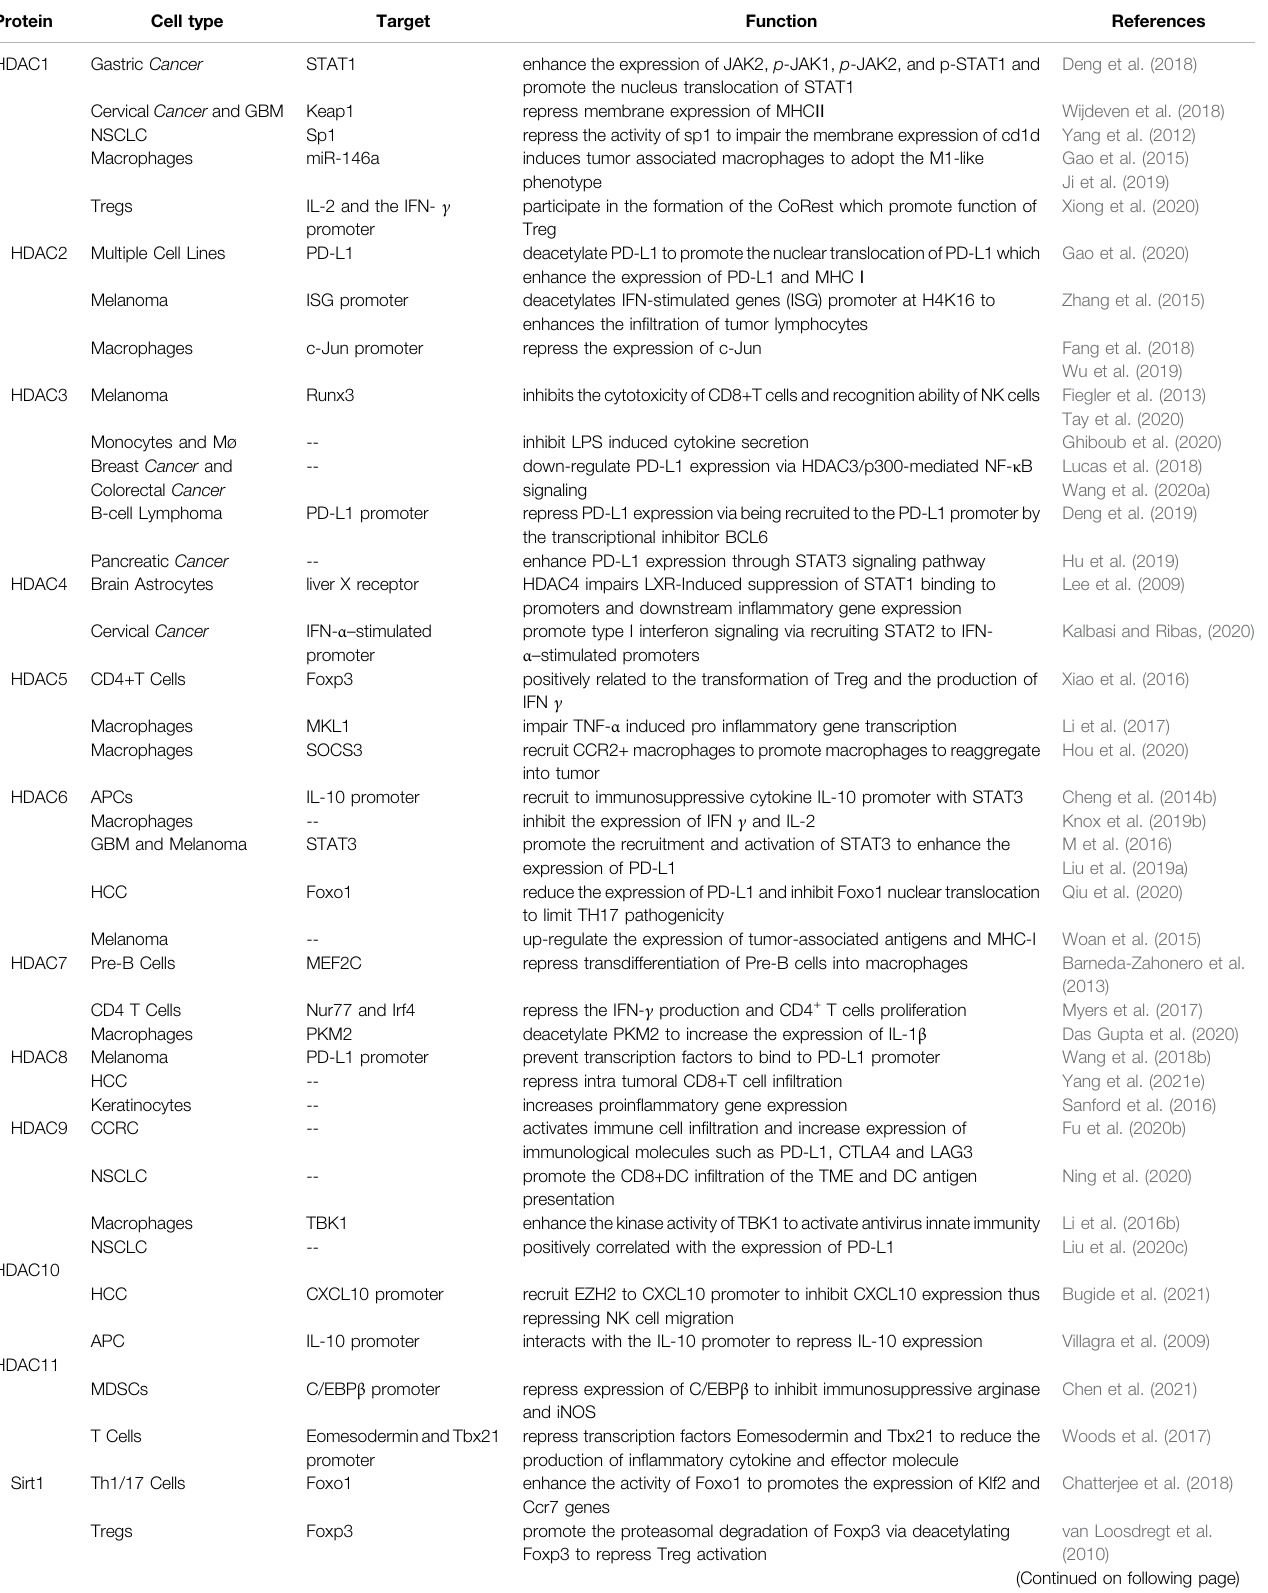
TABLE 2 | Function of HADCs related to tumor immunity in different cell types.